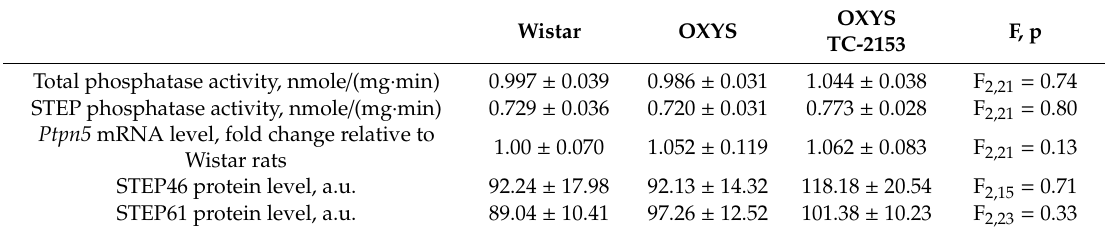
Table 1. The impact of chronic TC-2153 administration on total and STEP phosphatase activities as well as on STEP protein and Ptpn5 mRNA levels in the retina. Data are presented as the mean ± SEM.